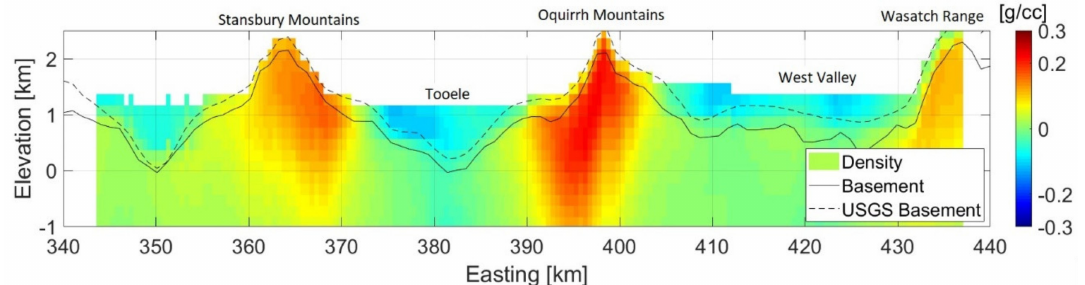
Figure 11. Vertical section along profile DD (cid:48) of 3D density model produced by the inversion without a priori model.